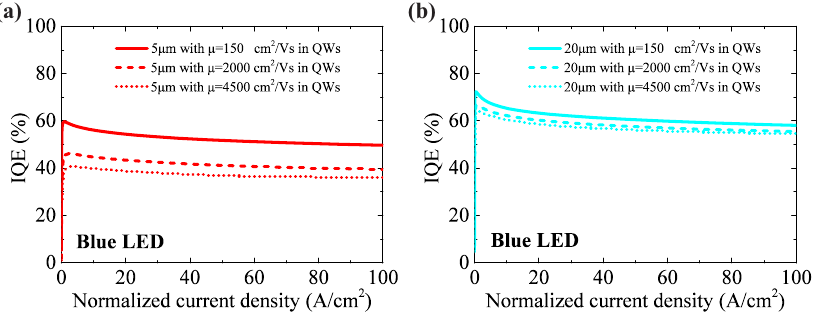
Figure 5. Influences of carrier mobility on the IQE of blue LED QWs with random alloy fluctuations: ( a ) 5 µ m and ( b ) 20 µ m dimensions. The carrier mobility in the blue LEDs ( µ n = 150 cm 2 /Vs, µ p = 10 cm 2 /Vs) increases gradually to become identical to the mobility in the red LEDs ( µ n = 4500 cm 2 /Vs, µ p = 190 cm 2